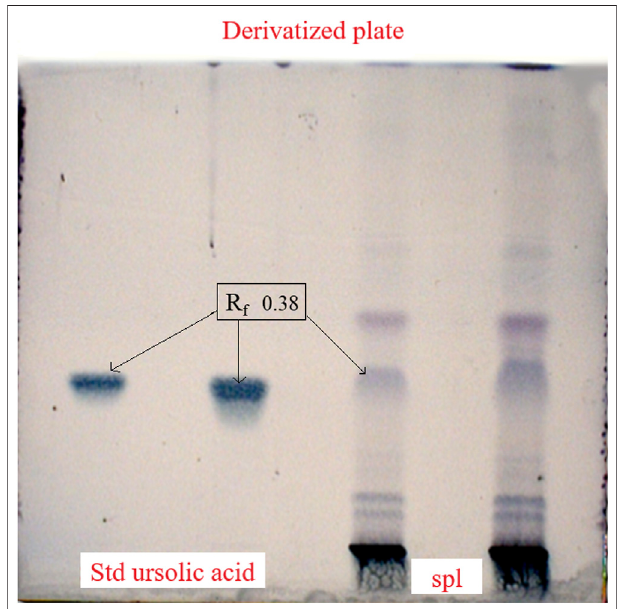
FIGURE 1 | HPTLC chromatogram of ursolic acid standard and plant extract with R f value.